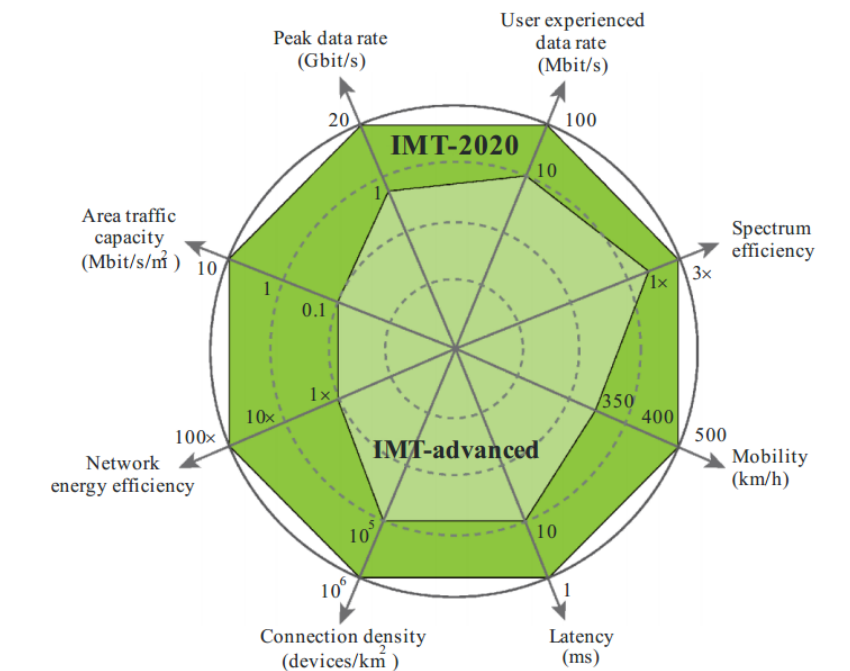
Figure 1. Enhancement of key capabilities from IMT-Advanced to IMT-2020